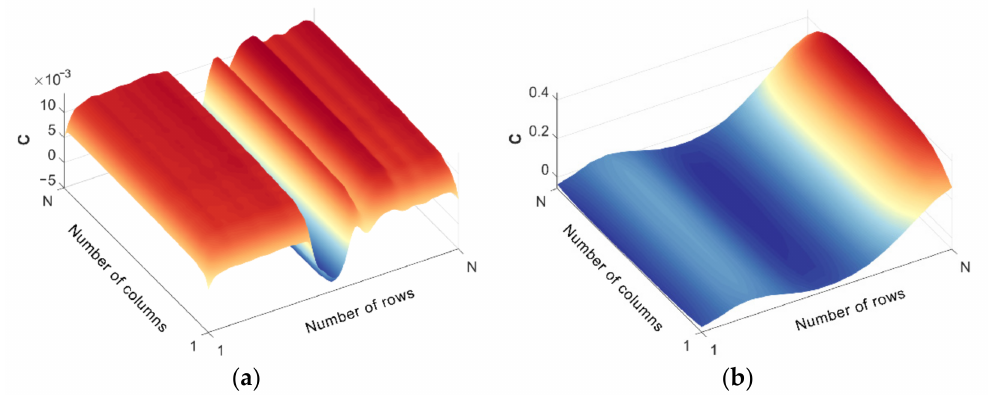
Figure 12. Cyclic Wiener filter: ( a ) bit rate is 0.4 Gbit/s; ( b ) bit rate is 2.5